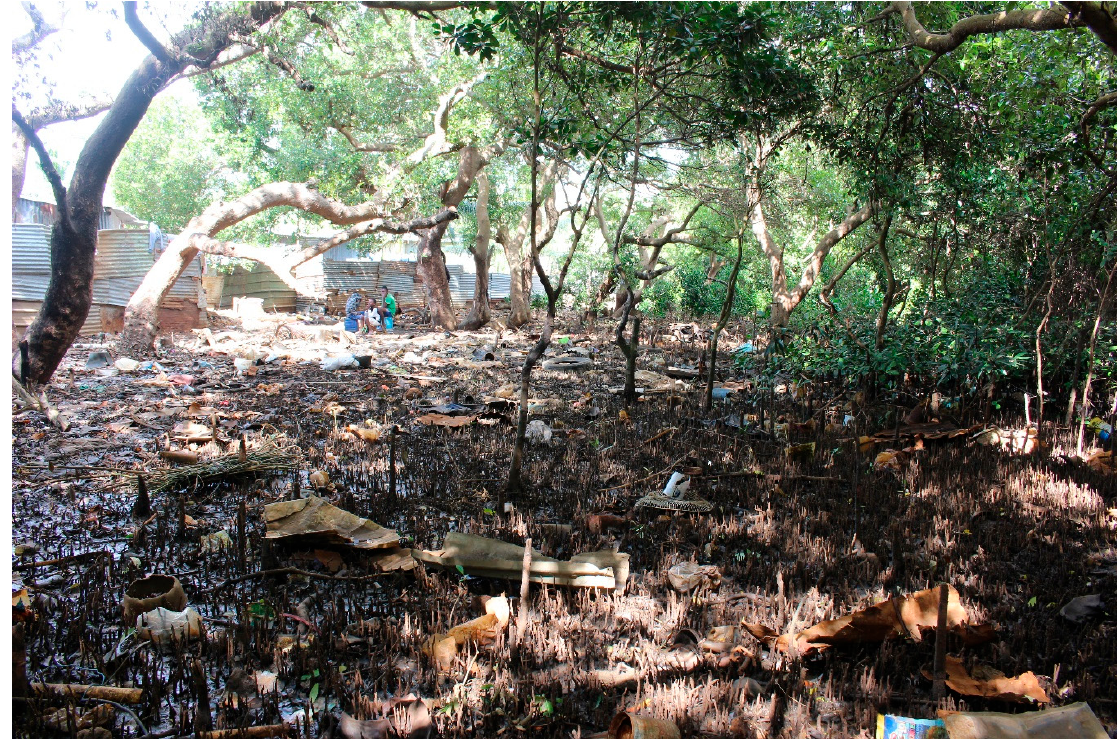
Figure 3. Recent cutting (2020) of Avicennia marina (Forssk.) Vierh. and Ceriops tagal (Pers.) C.B.Rob. next to the slum neighborhood of